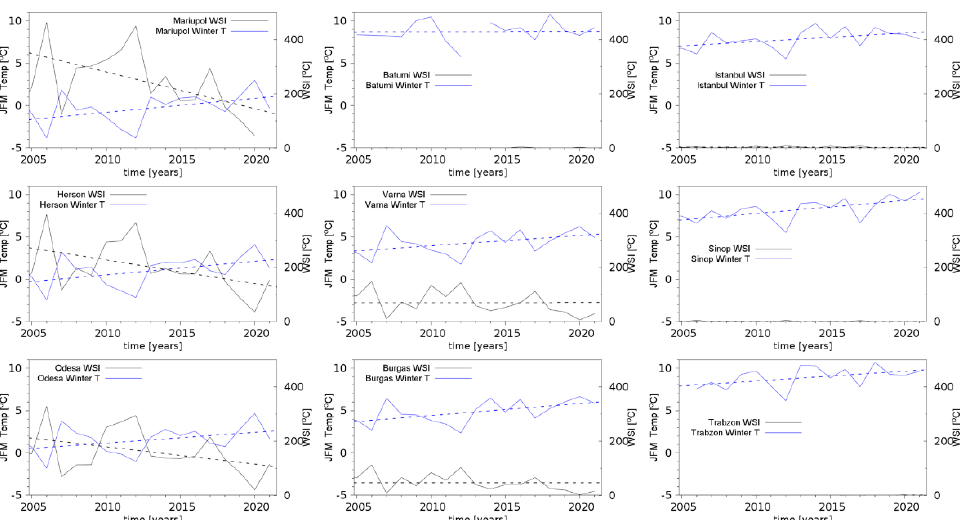
Figure 5. The mean winter (January, February, and March) temperatures in blue and WSI in black in Mariupol, Herson, Odesa, Batumi, Varna, Burgas, Istanbul, Sinop, and Trabzon, for the period 2006–2021. The trends of the curves are given with a dashed line in the corresponding color. Note that the WSI is close to zero along the south coast in Batumi, Istanbul, Sinop, and Trabzon. The periods with more than 20% data missing were not taken into consideration in this analysis.